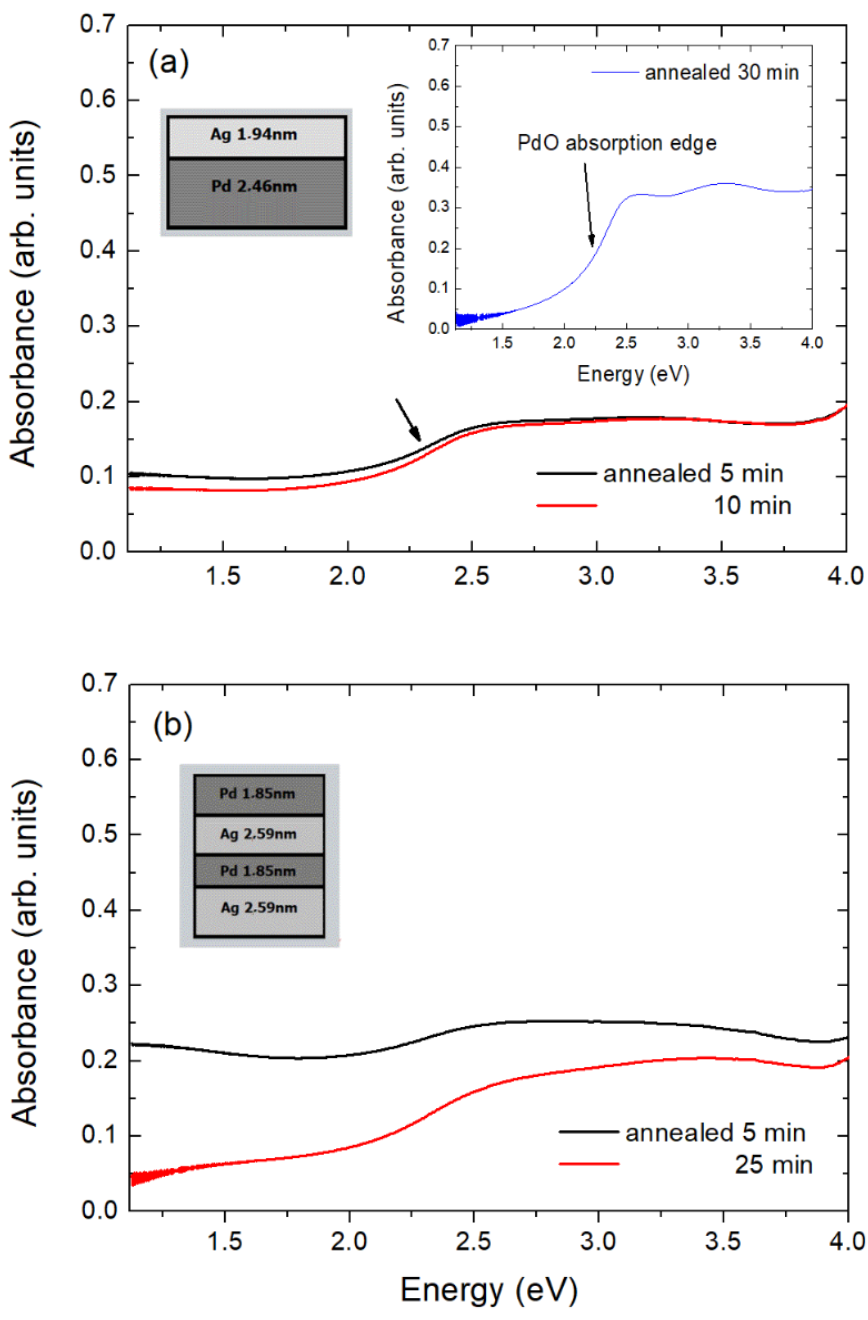
Figure 2. Absorbance spectra for thin Ag/Pd layered films grown on Corning glass and annealed at 460 °C. The relatively large concentration of Pd resulted in the formation of PdO (the edge is marked with arrows). Practically no LSPRs were detected in ( a ), while in ( b ), some broad LSPRs appear. For comparison, the PdO absorption edge recorded on a 10 nm film is plotted as an inset in ( a ).